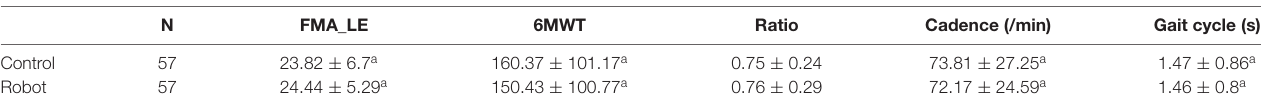
TABLE 1 | Assessment after 4 weeks of treatment on the subjects ( ¯ x ± s ).